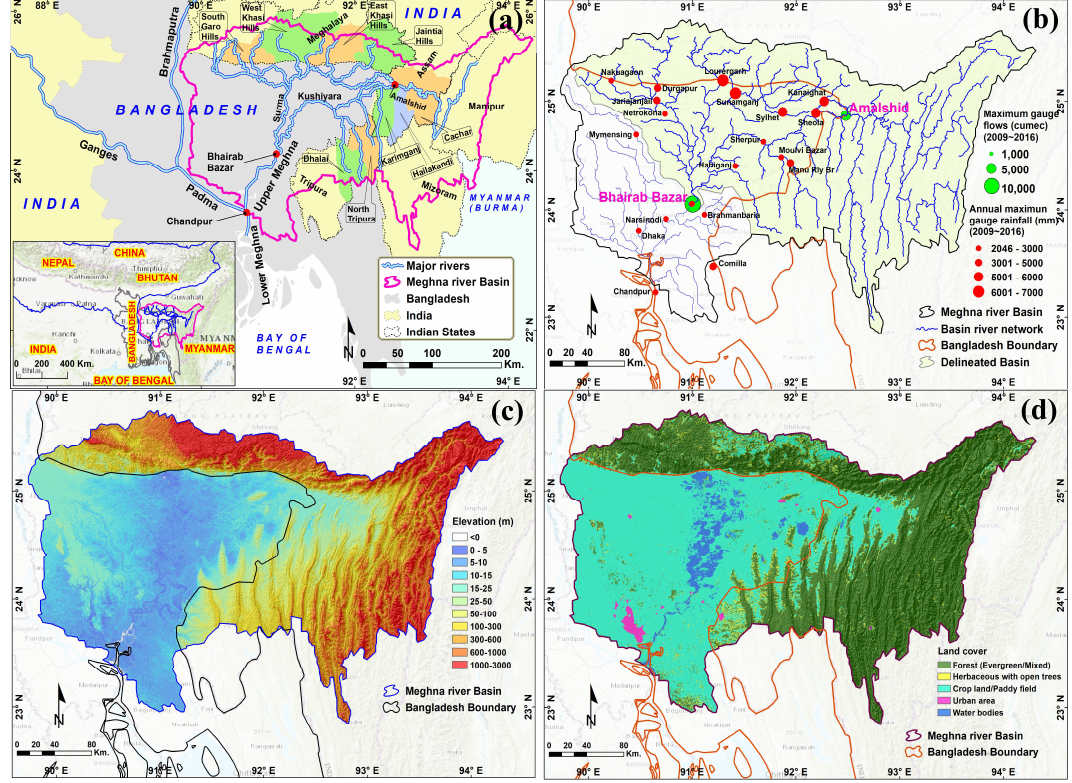
Figure 1. Topographic features of the study area. ( a ) The Meghna basin in the Asian continent (inset), showing major rivers and administrative details; ( b ) the Meghna basin with its detailed river network, including 20 rain-gauge stations (red bubbles) and two streamflow stations (green bubbles) in Bangladesh; ( c ) the HydroSHEDS (90 m resolution) digital elevation model of the Meghna basin; and ( d ) the land cover in the Meghna basin.